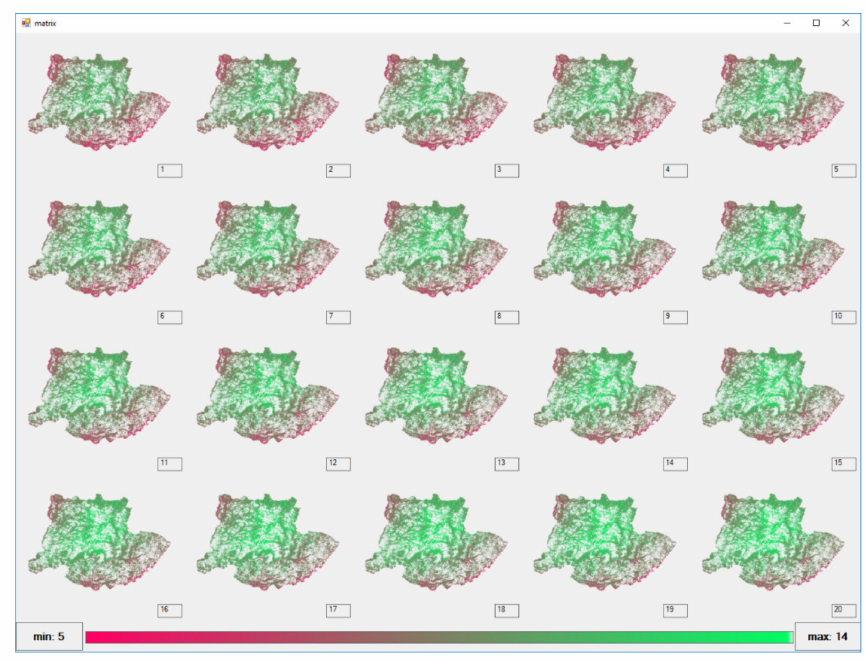
Figure A6. Price distribution for Scenario 1 (Biomass II (B 2 ), thinning) over a period of 20 years (t 1 to t 20 ) in the Nordeste region, Portugal. The minimum price was 5 € / m 3 (light red) and the maximum 14 € / m 3 (light